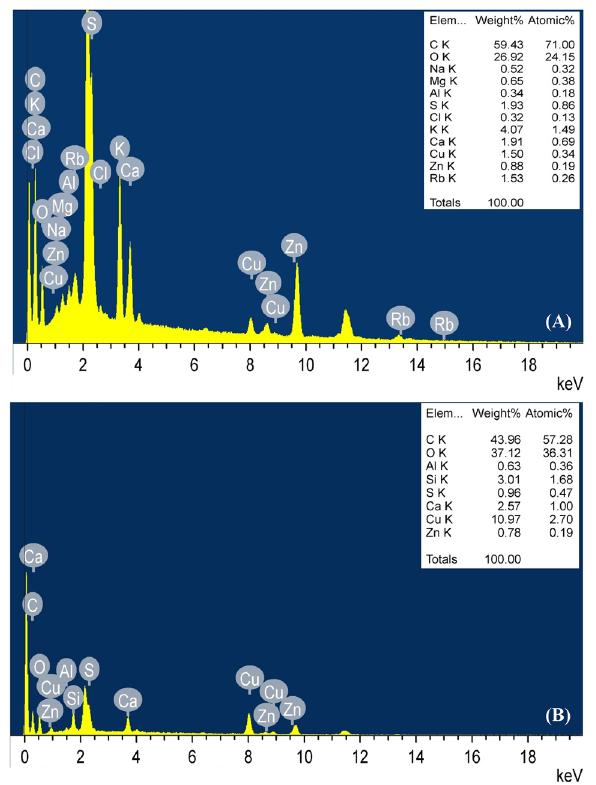
Figure 6. EDS micrograph of F. vesiculosus (A) before and (B) after biosorption of MO and copper ions from aqueous solution.